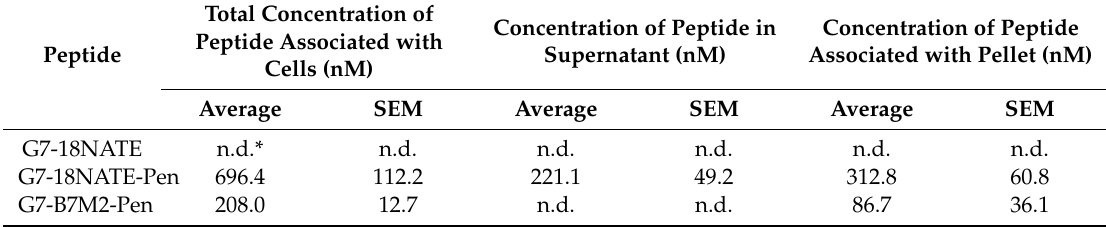
Table 3. Percentage of unbound G7-peptides associated with HeLa cell structures. % Unbound Peptide Peptide Associated with Total Cell